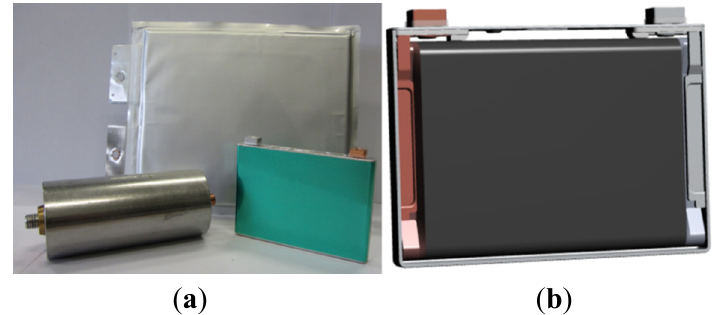
Figure 9. ( a ) Pouch (back), round (left) and prismatic (right) cell and ( b ) corresponding CAD model of the internal structure of the 5 Ah prismatic cell.